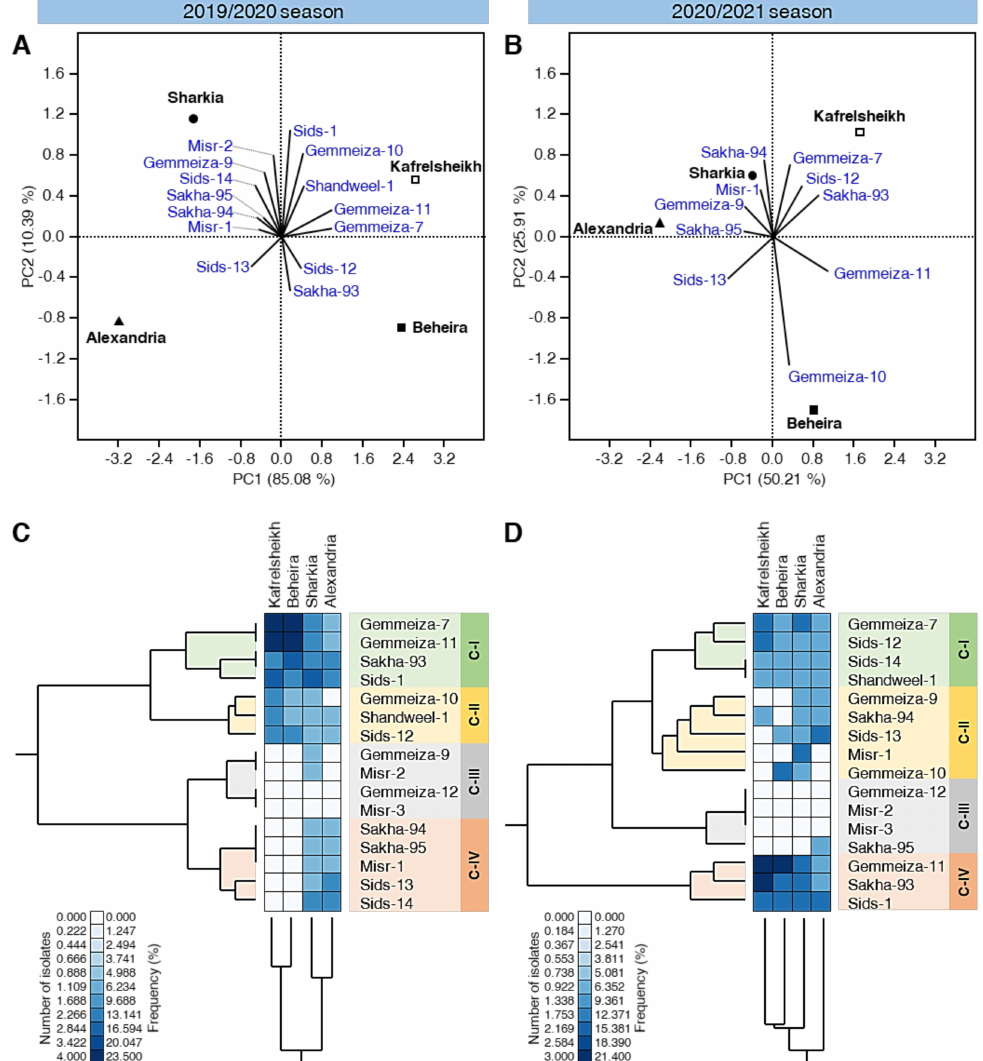
Figure 2. Principal component analysis (PCA) and two-way hierarchical cluster analysis (HCA) of individual commercial wheat cultivars growing in four main wheat-growing governorates in Egypt during the 2019/2020 and 2020/2021 seasons. ( A , B ) PCA-scatter plots and their associated loading plots using data collected during 2019/2020 and 2020/2021 seasons, respectively. ( C , D ) Standardized two-way HCA based on the number of isolates and frequency (%) of P. triticina races on 16 Egyptian commercial wheat cultivars growing in four main wheat-growing governorates in Egypt during the 2019/2020 and 2020/2021 seasons, respectively. The differences in the number of isolates and frequency (%) are visualized in the heat map diagram. Rows represent the individual cultivars, while columns represent the locations/ governorates. Low number of isolates and frequency (%) are colored light-blue and the high number of isolates and frequency (%) are colored dark-blue (see the scale at the left corner of the bottom of the heat